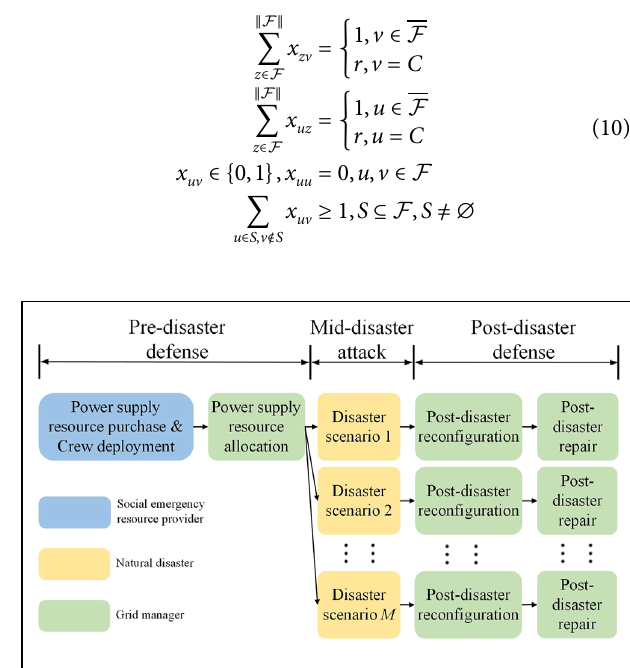
FIGURE 1 | Defender-attacker-defender model based on extensive-form